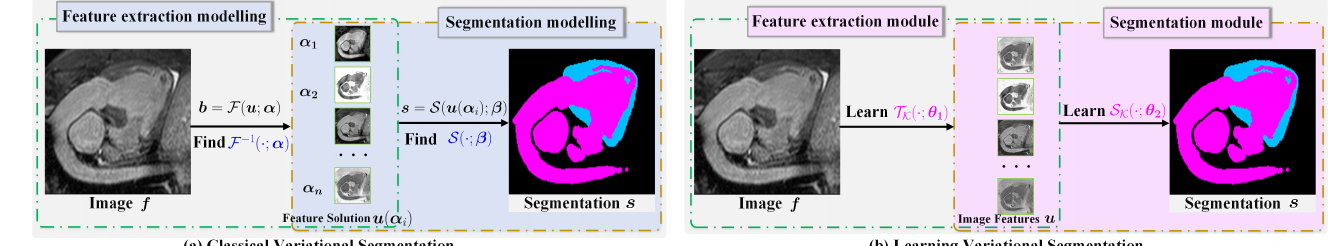
Figure 1. Classical variational image segmentation and model-inspired learning method. ( a ) The first stage solves the nonlinear differential equations using the classical iterative method, and then, the second stage thresholds the smooth solution in the first stage to extract objects. ( b ) The first stage learns the solution mapping T K ( f ; θ 1 ) by optimizing the convolution kernel θ 1 to extract image features. The second stage learns the feature fusion and segmentation thresholding